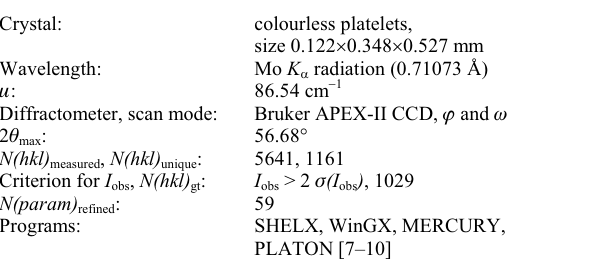
Table 1. Data collection and handling.